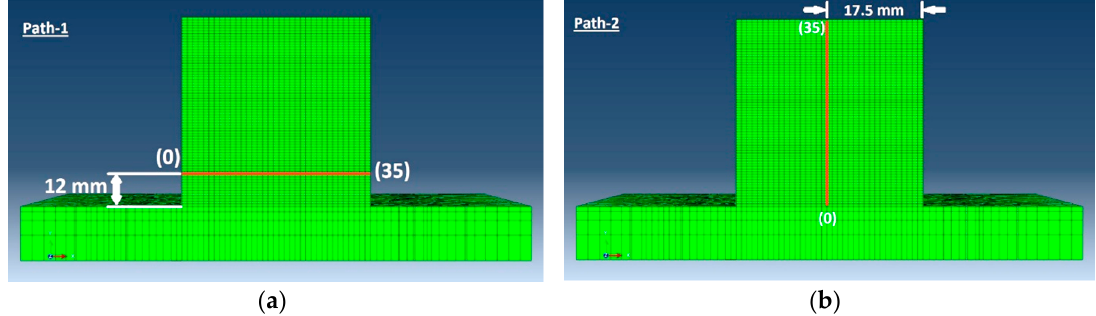
Figure 19. ( a ) Path-1 position and direction start from the left edge of the cube marked as (0), ends at the right edge (35); ( b ) Path-2 position and direction start from the surface of the base plate marked as (0) ends on the surface of the printed cube i.e., 35 mm height marked as (35).